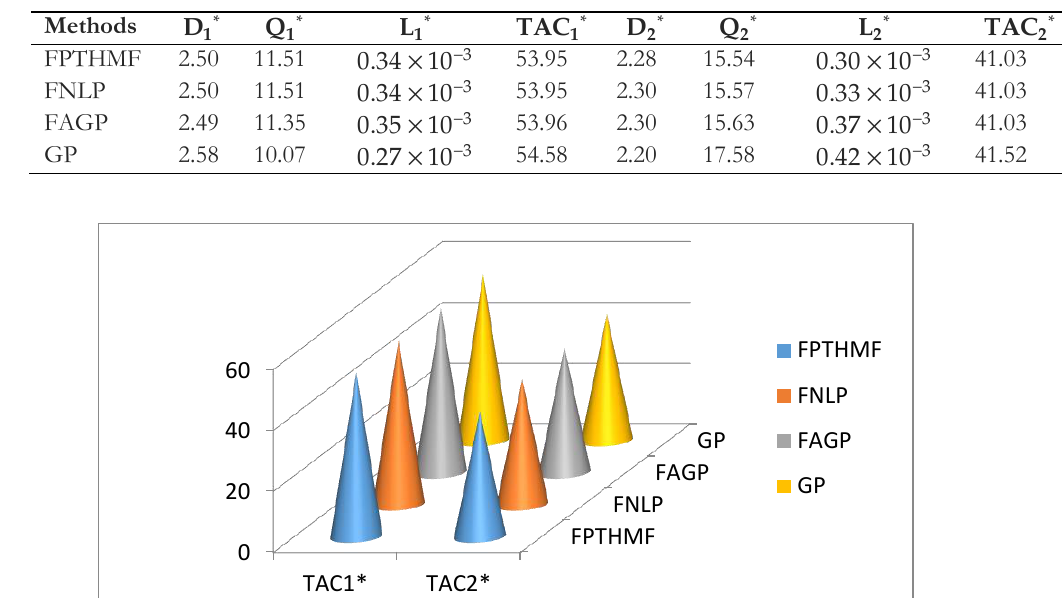
Fig. 2. Minimizing cost of both items using different methods.